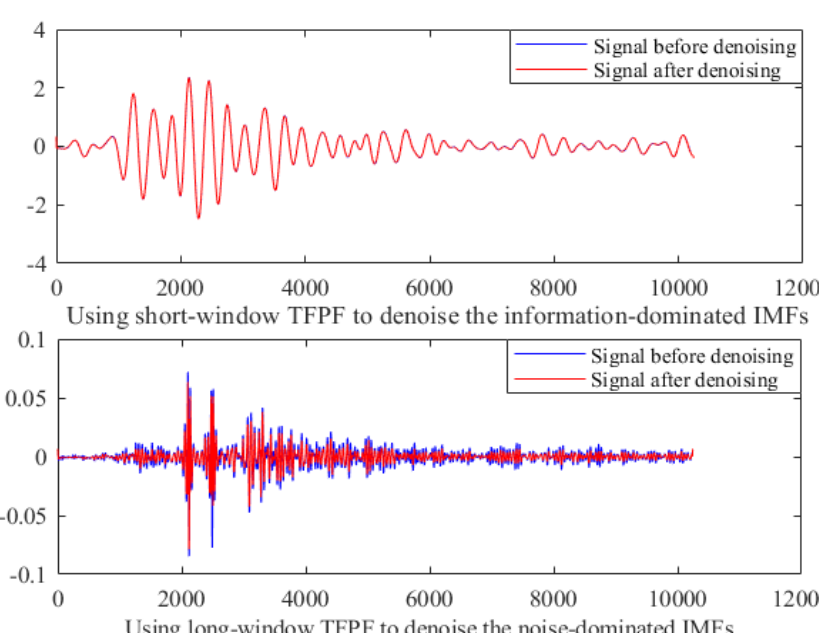
Figure 16. TFPF with different window lengths is selected for denoising.